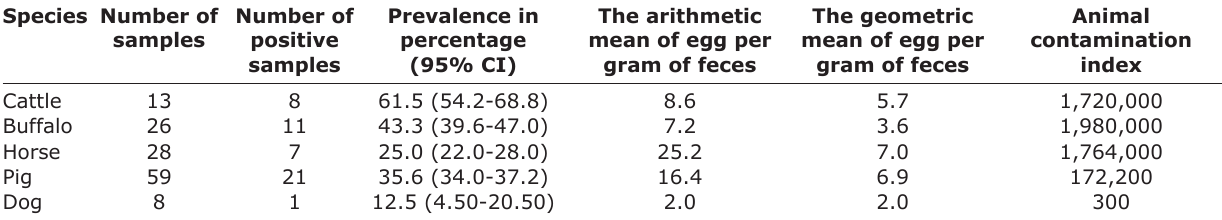
Table-2: The prevalence, intensity of infection (arithmetic and the geometric mean of eggs per gram of feces), and animal contamination index of S. japonicum in animals in the Lindu Subdistrict. Species Number of samples